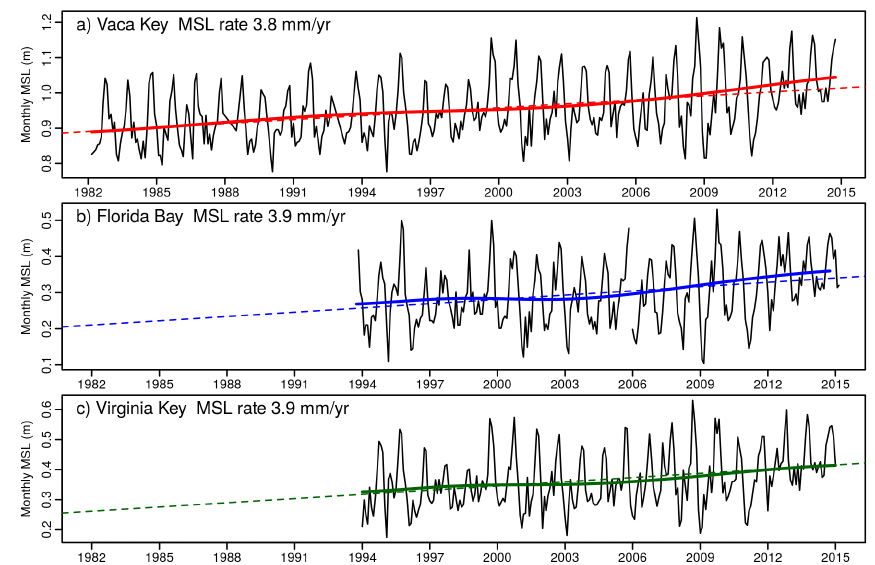
Figure 4. Monthly mean sea levels at (a) Vaca Key, (b) Florida Bay, and (c) Virginia Key, Florida. Solid lines show the EMD residual (red at Vaca Key, blue in Florida Bay, green at Virginia Key), dashed lines plot linear regression of the monthly mean sea level with the annual cycle removed.